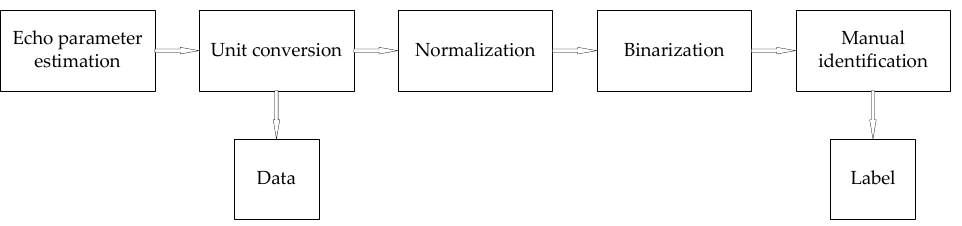
Figure 2. The procedure of producing dataset.